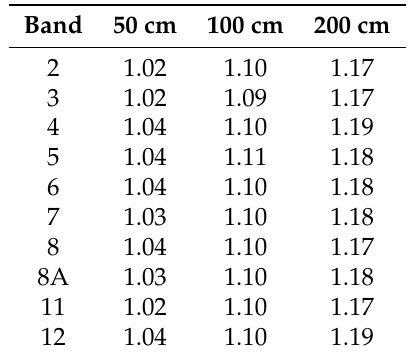
Table 4. Relative reflectance in each band at voxel sizes of 50, 100, and 200 cm. After calculating the average reflectance across the forest from each voxel size, reflectance was derived by dividing these with simulated reflectance while using 20 cm voxel size. In this forest, the reflectance simulated from the 20- and 200-cm voxel models only varied about 1.2